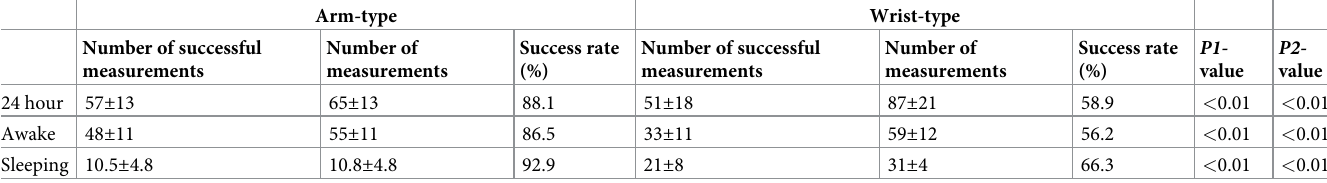
Table 2. Numbers and percentages of successful blood pressure readings by the two monitors (n =